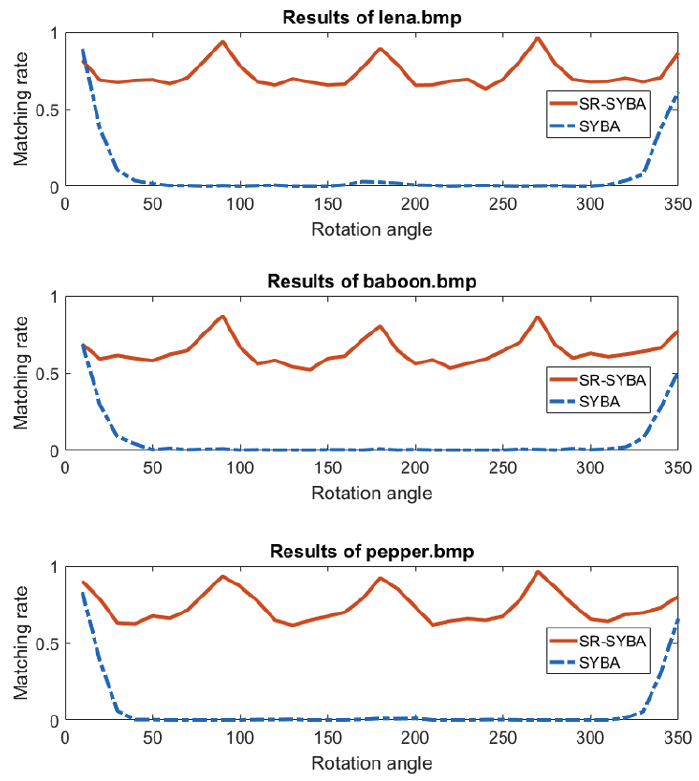
Figure 12. Matching rate comparison between SR-SYBA and SYBA with rotation variations.